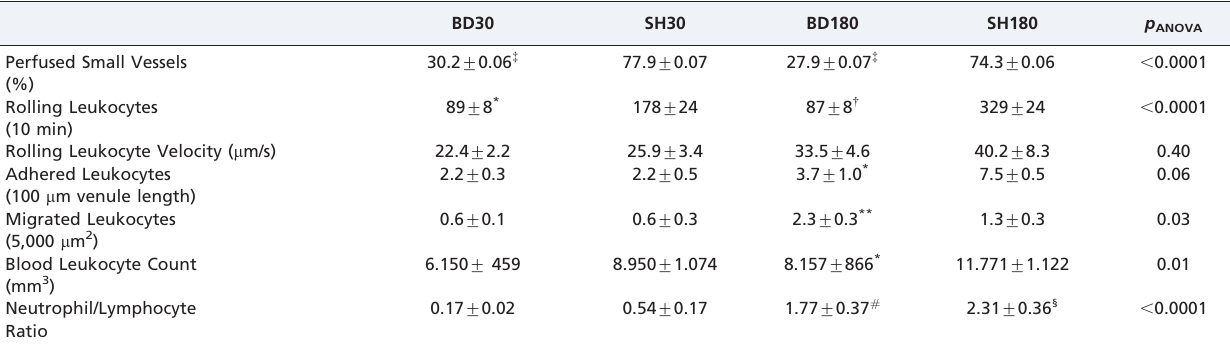
Table 1 - Intravital microscopy of the rat mesenteric microcirculation.